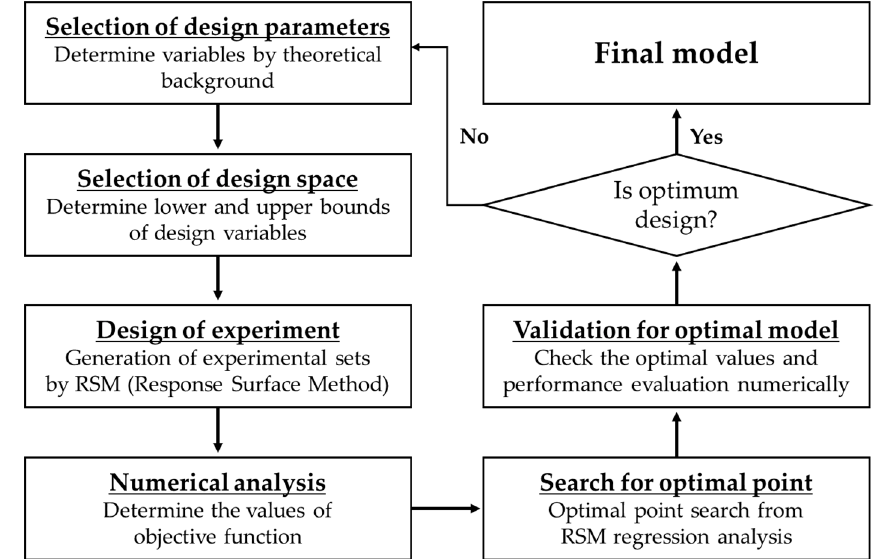
Figure 5. Optimization procedure for the pump impeller.